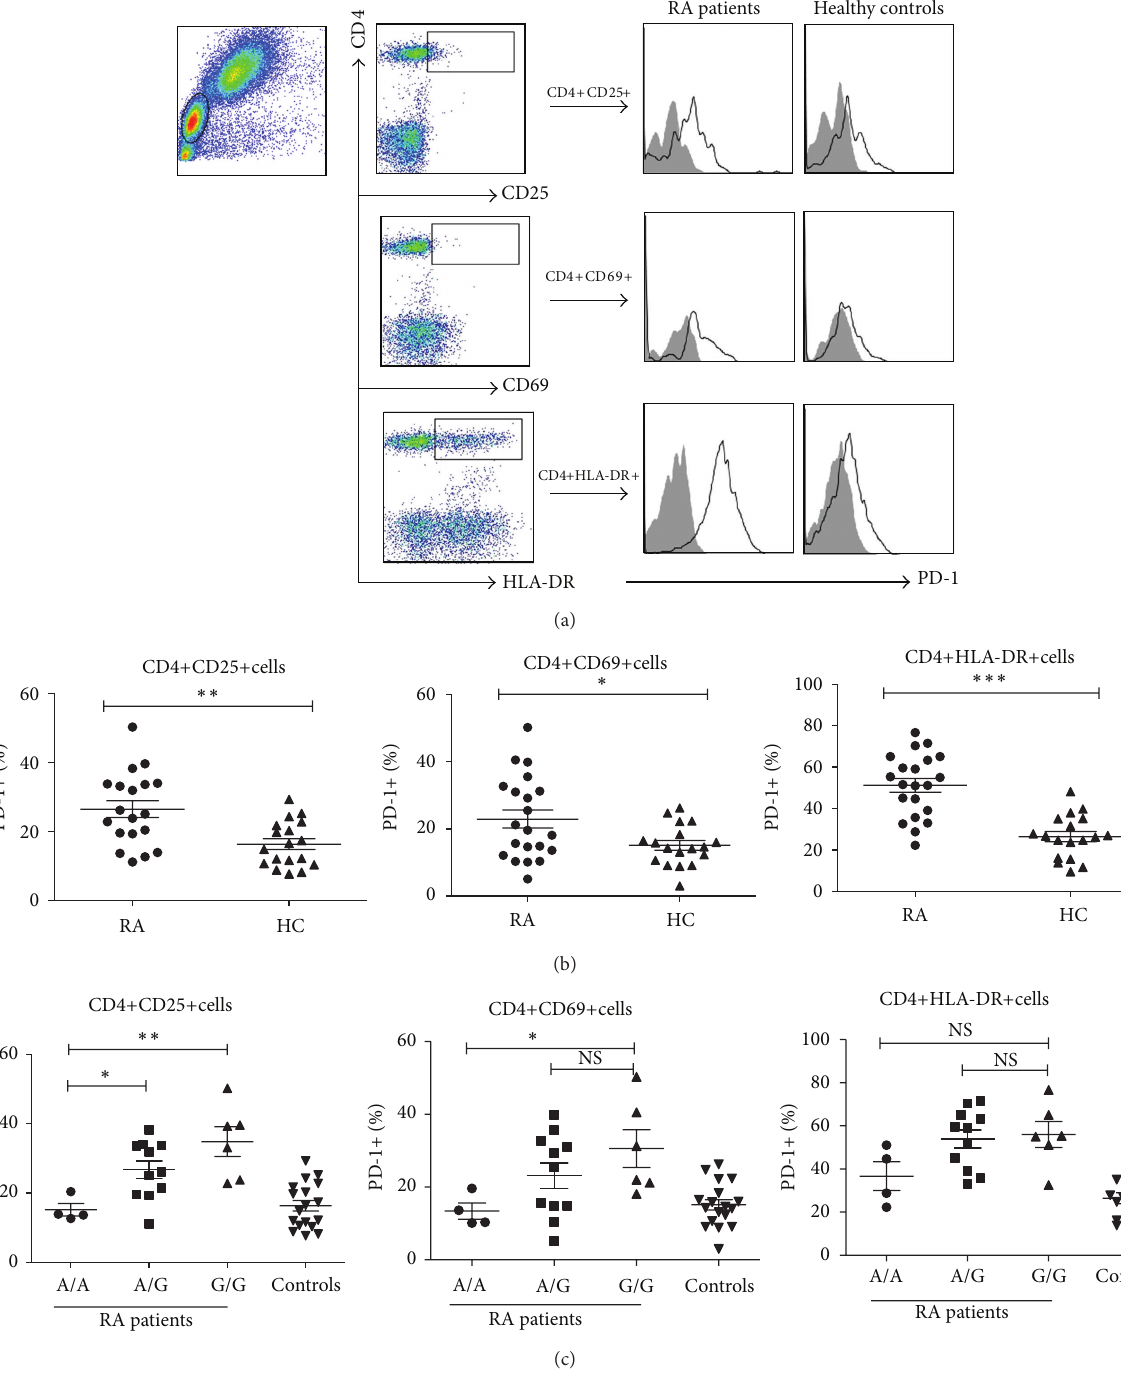
Figure 2: Increased basal programmed death 1 (PD-1) expression on activated CD4+ T cells in RA patients. (a) A representative flow cytometry analysis of PD-1 expression on CD4+ T cells in RA patients and healthy controls is shown. (b) Upregulated expression of PD- 1 on CD4+CD25+, CD4+CD69+, and CD4+HLA-DR+ T cells from RA patients, as compared with those from healthy controls. (c) RA patients homozygous for the rs36084323 SNP (G/G) have significantly increased percentages of PD-1+activated CD4+CD25+, CD4+CD69+, and CD4+HLA-DR+ T cells compared with healthy controls and rs36084323 A/A RA patients ( ∗ = 𝑃 < 0.05 , ∗∗ = 𝑃 < 0.01 , by Mann-Whitney 𝑈 test). Horizontal bars indicate the mean ±